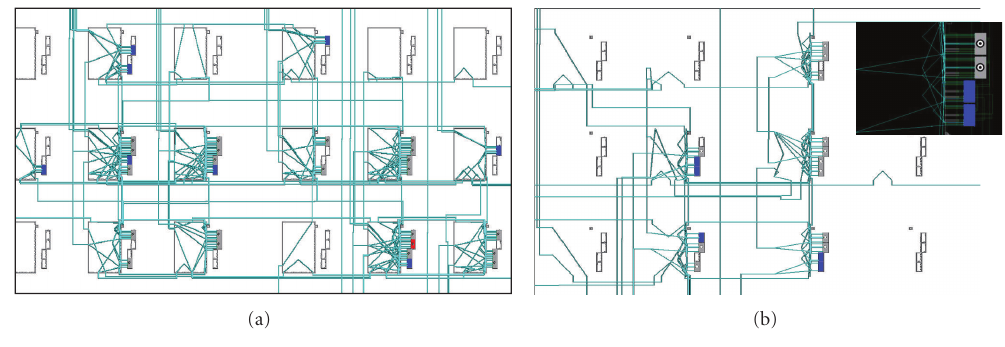
Figure 8: (a) The FPGA editor snapshot showing the layout of the 22-cell SPCA, using 30 slices (small, colored boxes). (b) The FPGA editor view of a portion of the CA + LFSR implementation. The inset shows a pair of hard macros used to realize the CAs.